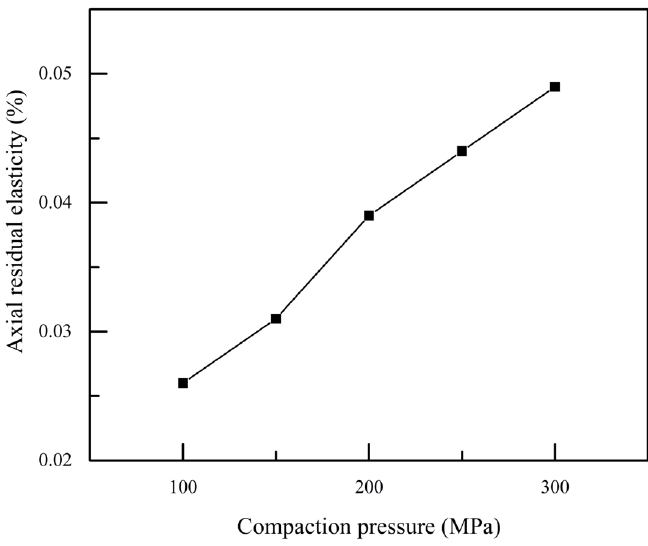
Figure 29. Curve of variation of axial residual elasticity with compaction pressure.